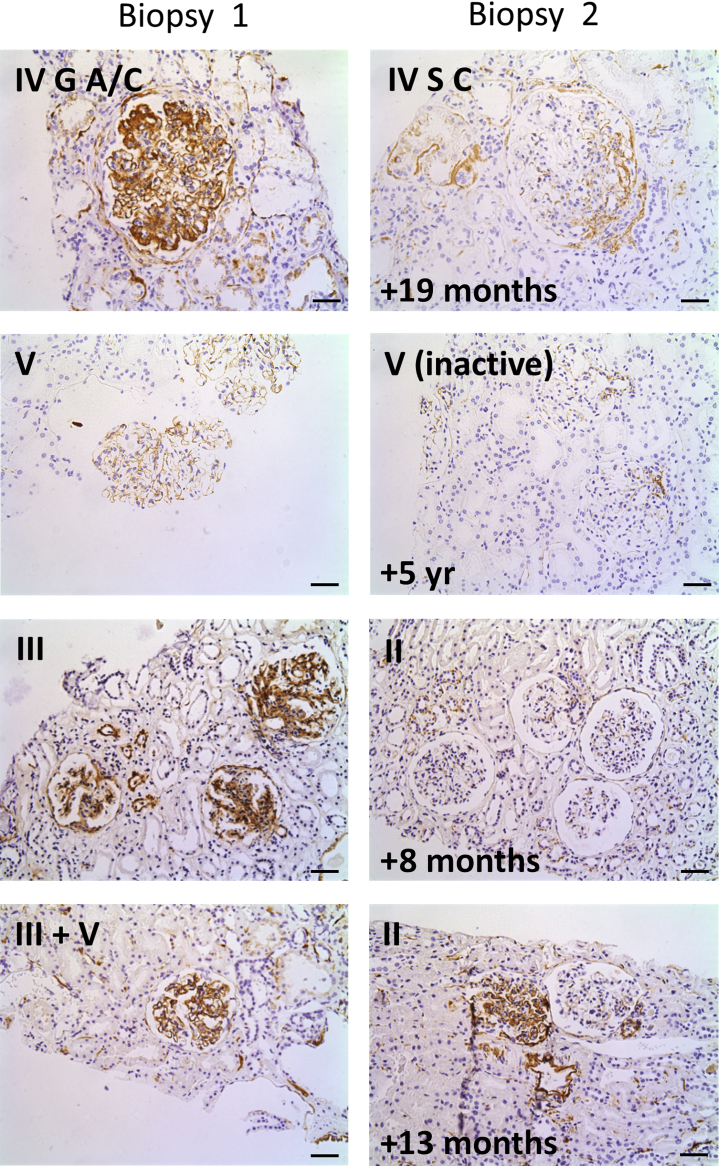
Glomerular C5b-9 staining in serial biopsies. Representative C5b-9 staining in sequential renal biopsies pretreatment (biopsy 1) and posttreatment (biopsy 2), with varying interbiopsy intervals. Original magnification ×20. Bar = 50 μm. To optimize viewing of this image, please see the online version of this article at www.kidney-international.org.